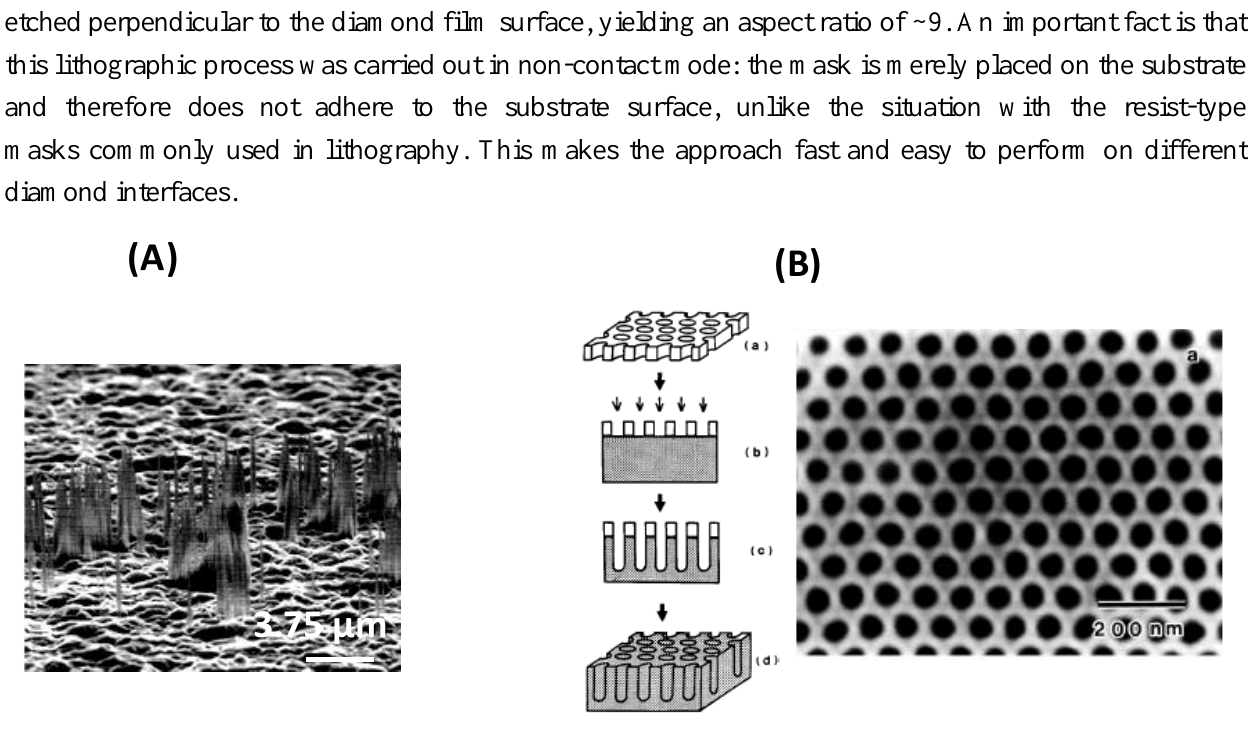
Figure 3. ( A ) SEM images of diamond nanowiskers formed on as-grown diamond films coated with 400 nm thick Al layer using reactive ion etching (RIE) with oxygen plasma (reprint with permission from [16]); ( B ) Formation of honeycomb diamond films (reprint with permission from